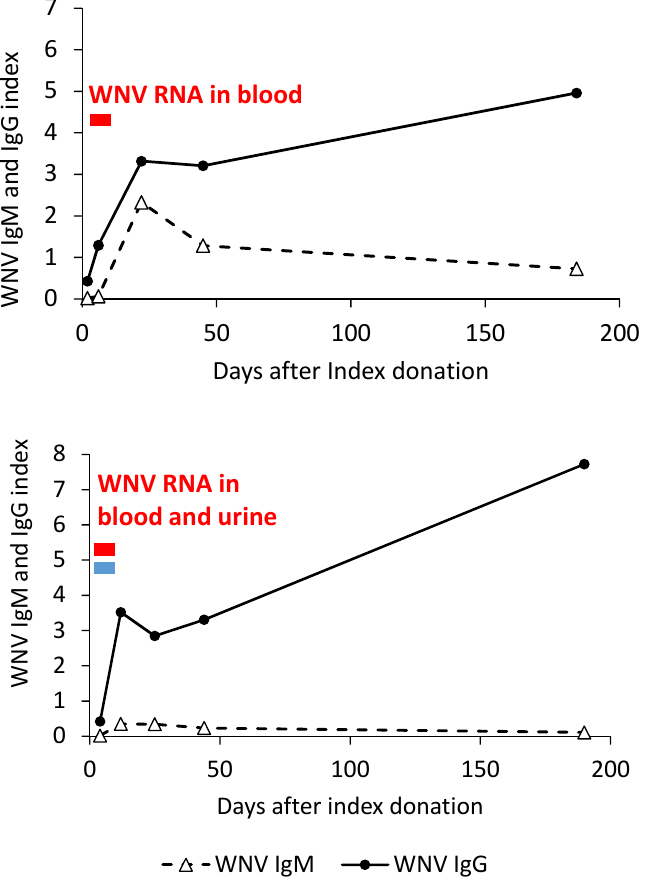
Figure 5. WNV IgM and IgG antibodies in serum and WNV RNA in the blood and urine of two blood donors with WNV infection and a blunted WNV IgM response, Veneto region, northern Italy, 2018.